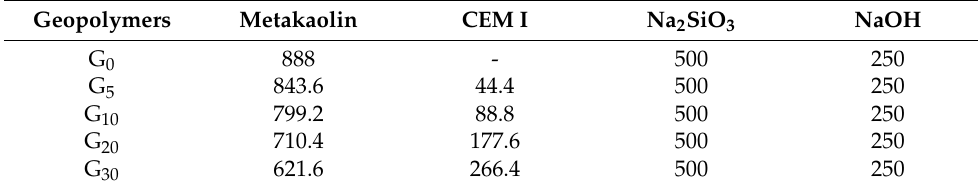
Table 3. Mixed proportion of geopolymers/(kg/m 3